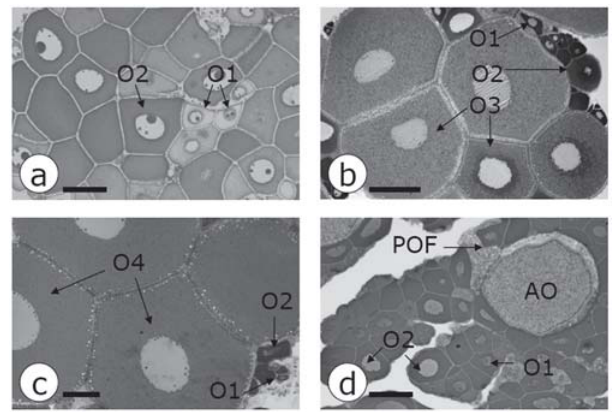
Fig. 2 . Histological sections of yellow-mandi ovaries at dif- ferent stages of gonadal maturation; tissues were fixed in 5% buffered glutaraldehyde and then post-fixed in Bouin’s fluid; bars = 100 µm. a) Resting stage: chromatin nucleolar (O1) and perinucleolar (O2) were the only types of oocytes present. b) Maturation stage: besides O1and O2 oocytes, the ovary con- tained yolk vesicle oocytes (O3). c) Mature stage: at this stage the ovaries showed chromatin nucleolar (O1), perinucleolar (O2) and vitellogenic (O4) oocytes. d) Spawned stage: postovulatory follicle (POF) was a striking structure present in the ovaries at this stage; atresic oocyte (AO); chro- matin nucleolar (O1) and perinucleolar (O2) oocytes were also observed.